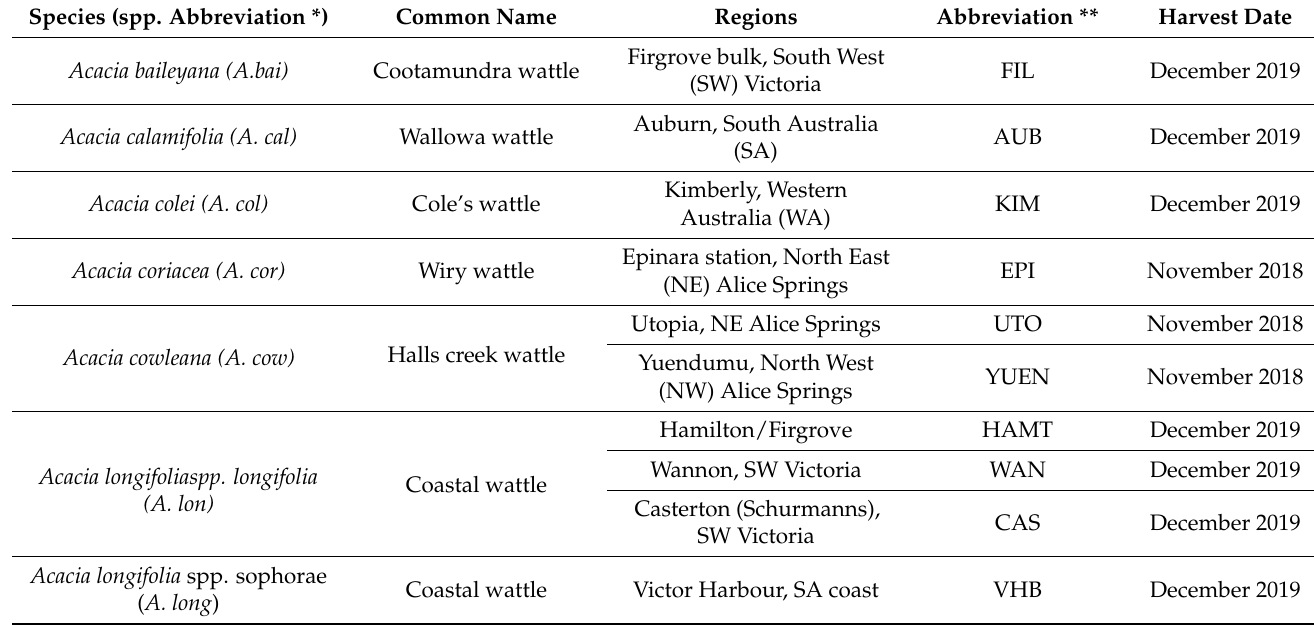
Table 1. The Australian acacia species used in this study showing their regions and harvest